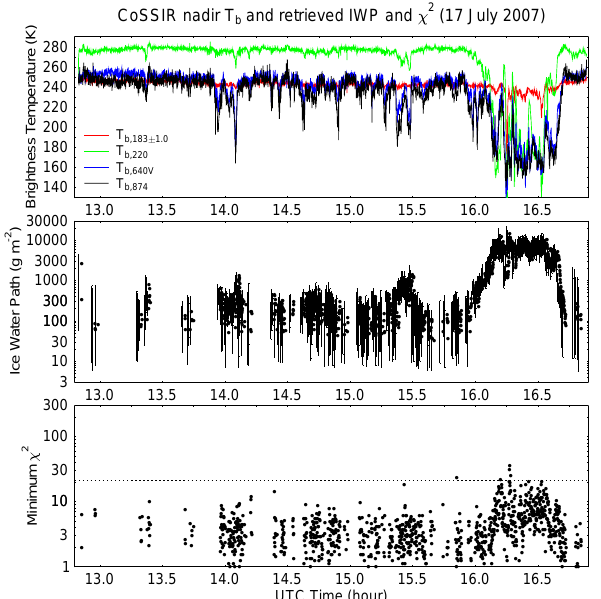
Fig. 12. CoSSIR brightness temperatures from 8 August for four channels (top panel). Retrieved ice water path with error bars of cloudy pixels (middle panel). Minimum χ 2 (bottom panel); the dot- ted line at χ 2 of 16.8 is the 99% significance level for 6